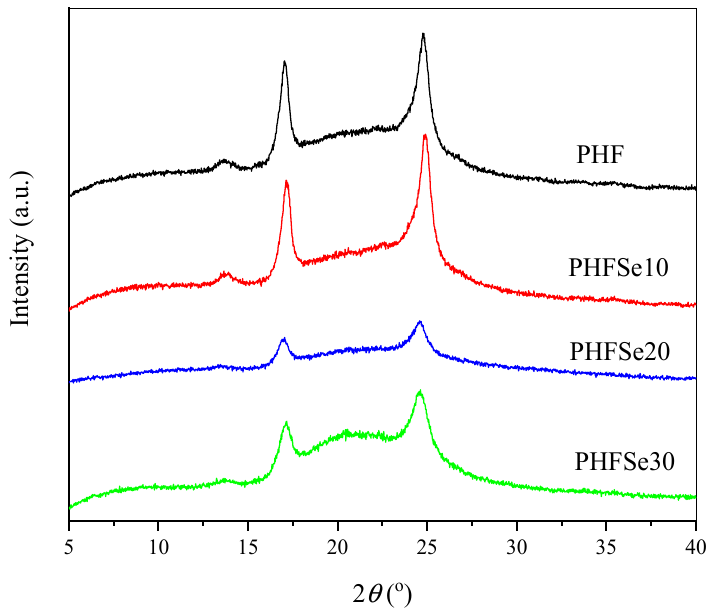
Figure 8. WAXD patterns of PHF and PHFSe copolyesters.